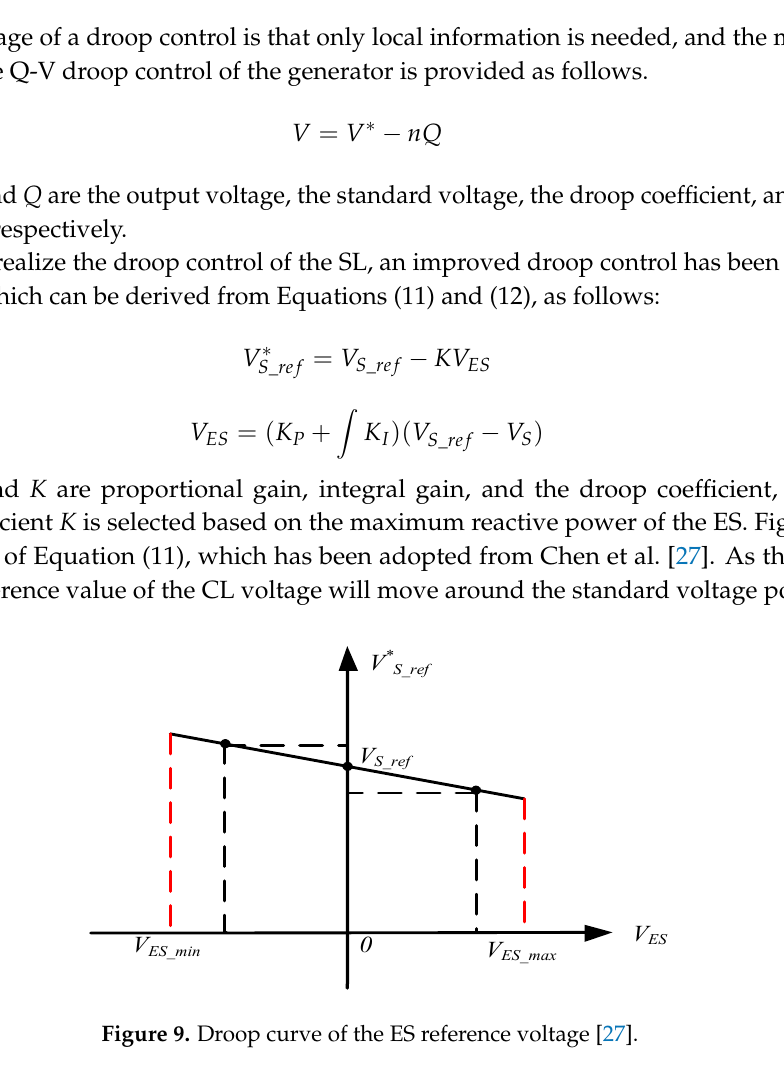
Figure 8. Schematic of microgrid with distributed ESs.